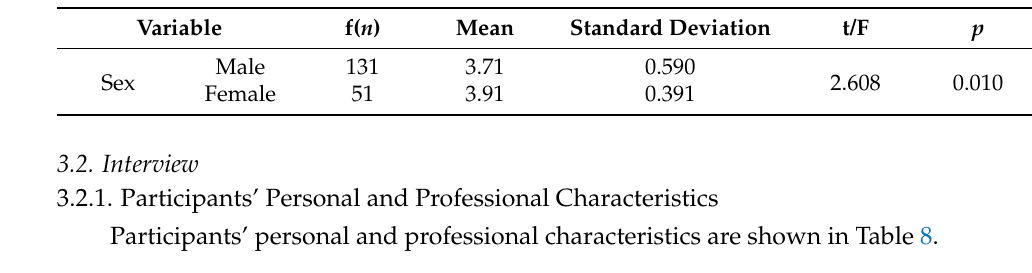
Table 7. Spatial quality factor in relation to the respondents’ personal and professional characteristics.